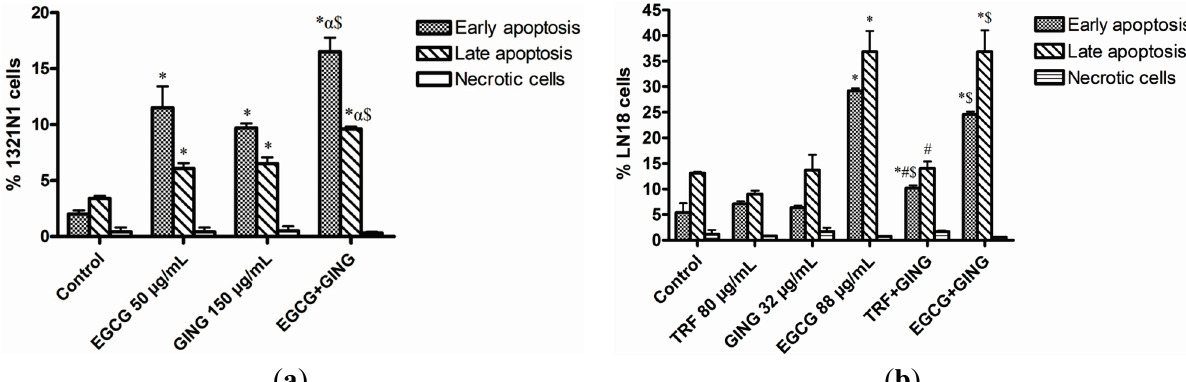
Figure 5. Combined treatments potentiate apoptosis-mediated cell death in 1321N1 and LN18 cells. 1321N1 and LN18 cells were treated with combined treatments at IC 50 concentrations for 24 h. Bar graph representing mean values from three independent experiments for ( a ) 1321N1 and ( b )